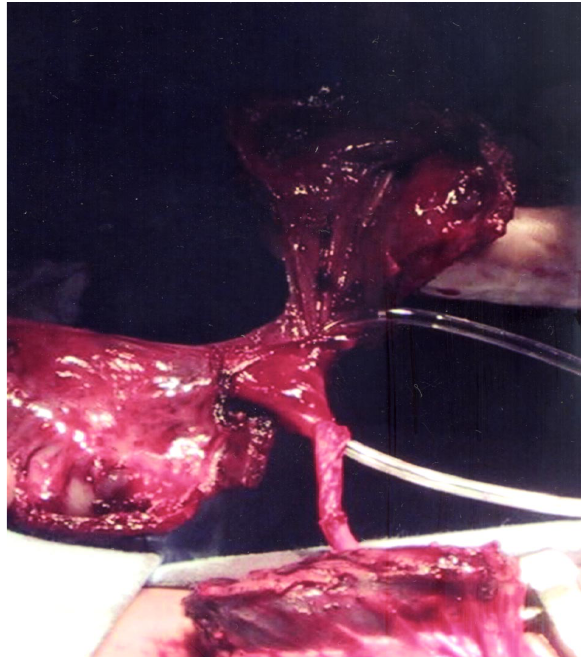
Figure 2 – The entire upper pole is dissected and incised in 2 portions. Note the catheter in the upper ureter close to the ure- teropelvic junction.